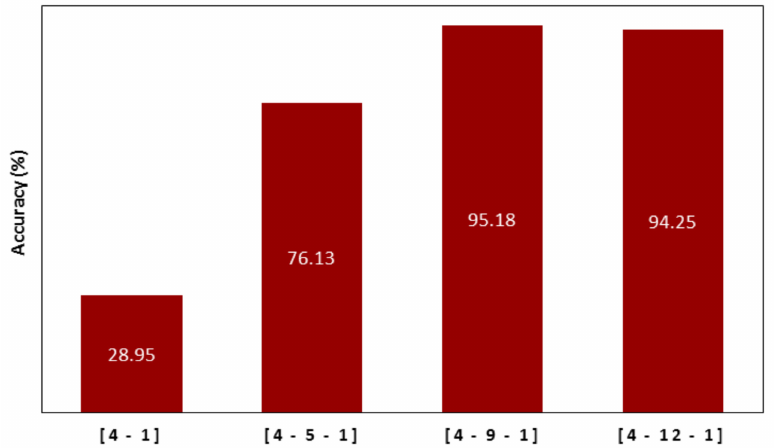
Figure 14. The overall accuracy of neural networks with different structures and number of